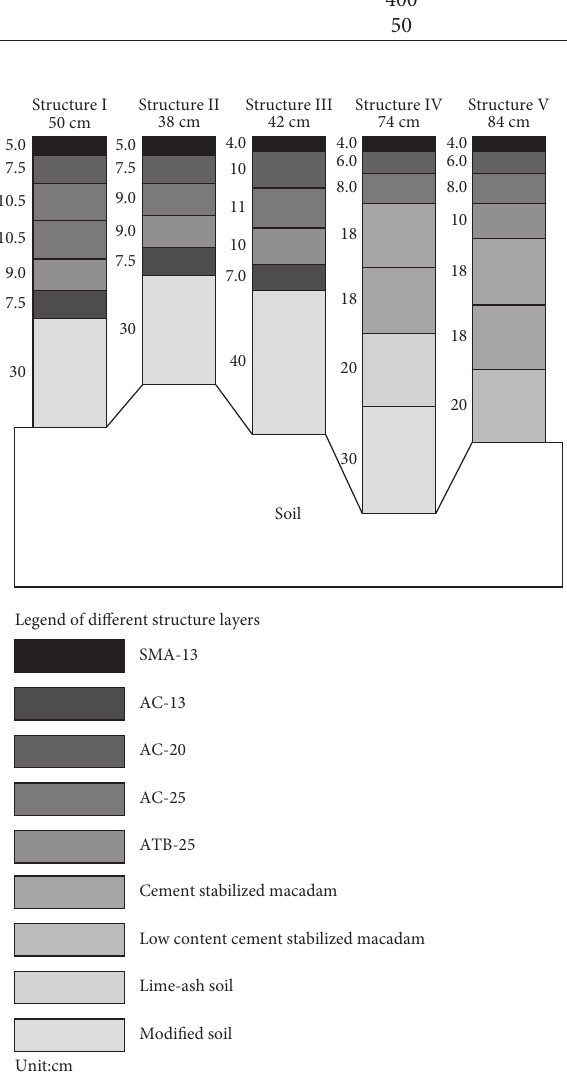
Figure 1: Pavement structure and